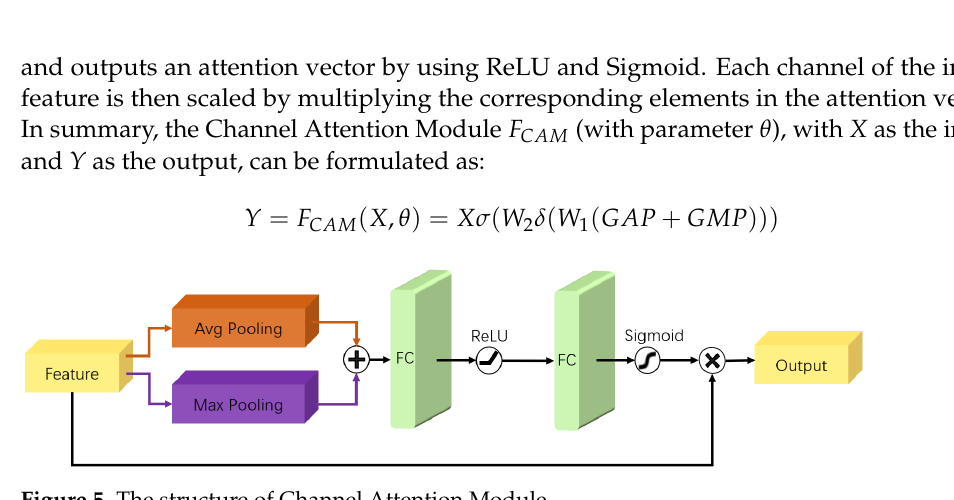
Figure 5. The structure of Channel Attention Module.